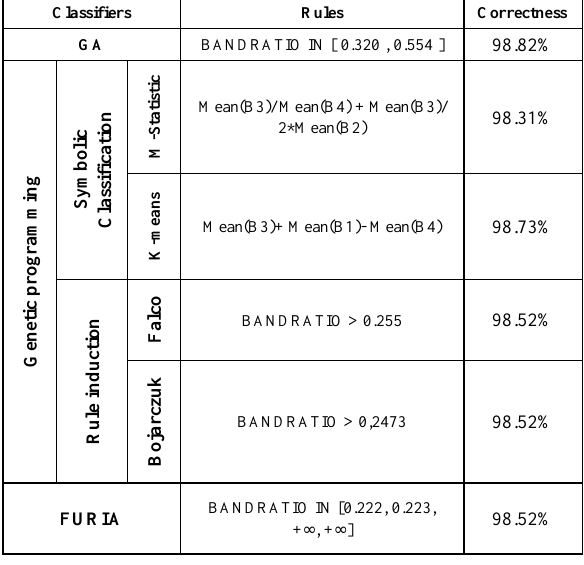
Table 1. Extraction of vegetation